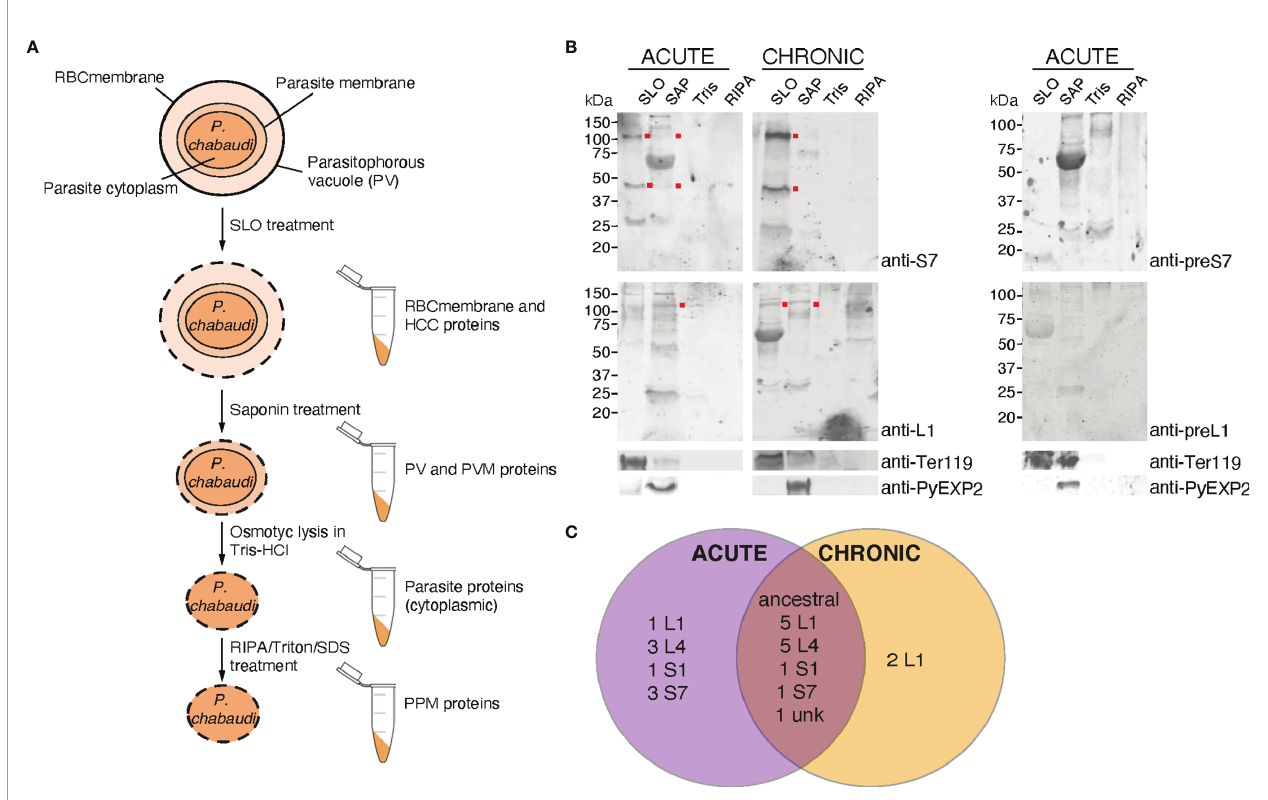
FIGURE 6 | Subcellular fractionation of P. c. chabaudi AS iRBC and localisation pattern of the PIR proteins. (A) Schematic representation of the fractionation work fl ow used to map the subcellular localisation of P. chabaudi PIR proteins. Brie fl y, P. chabaudi iRBC at the trophozoite-stage were magnetically enriched and treated with SLO, prior to being centrifuged to obtain a supernatant and a pellet fraction. Proteins localised on the iRBC membrane and cytoplasm are expected to be found in the supernatant. The pellet was then treated with saponin to release all proteins localised on the PV and PVM. Following centrifugation, the resulting pellet was incubated with Tris-HCl hypotonic lysis buffer and frozen. Following osmotic shock of the cells, proteins localised within the parasite cytoplasm are expected to be released. The remaining parasite membrane-associated proteins were extracted by treating the resulting pellet with RIPA lysis buffer enriched with SDS and Triton. The lysed membrane following each treatment is represented by a dotted line. The composition of each pellet sample obtained is also indicated. RBCmembrane: Red Blood Cell membrane, PV; Parasitophorous Vacuole, PPM; Parasite Plasma Membrane, PVM; Parasitophorous Vacuole Membrane, HCC; Host-Cell Cytoplasm. (B) Western blot analysis of P. chabaudi trophozoite fractionated protein samples, under reducing conditions. Fractionated samples were prepared from infected blood of C57Bl/6 RAG1 -/- mice during acute- and chronic-phases of infection. Red dots indicate the estimated average size of the monomers or dimers of each PIR clade (S7 33-37 kDa and L1 75-151 kDa). Probing with pre-immune sera served as negative control. Antibodies against the mouse erythroid- speci fi c marker Ter119 and Plasmodium EXP2 were used as stage-speci fi c controls as well as to assess the samples purity. The molecular weights on the right indicate the positions to which size markers had migrated. SLO, Streptolysin-O fraction; SAP, Saponin fraction; Tris, Tris-HCl lysis. (C) Venn diagram depicting the overlap between the PIR proteins identi fi ed by mass spectrometry in all fractionated samples prepared from acute- and chronic-stage P. chabaudi infected erythrocytes. All PIR proteins identi fi ed in each set of samples are listed in Tables 1 and 2